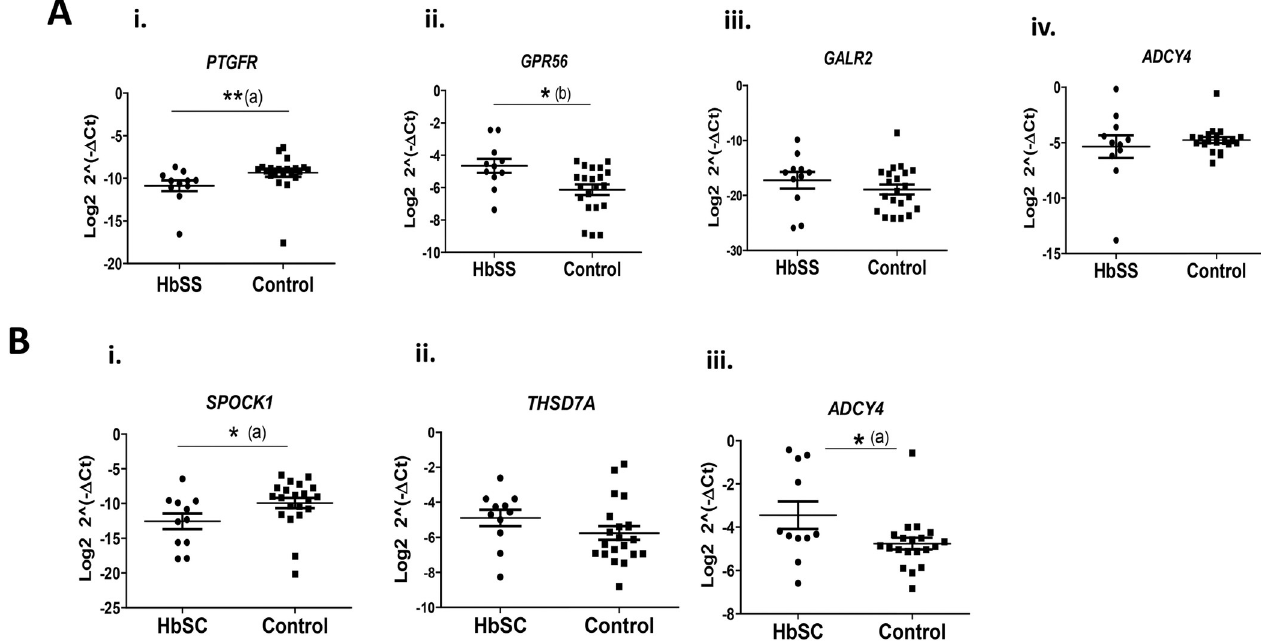
Fig 7. Expression levels of genes in the HbSS and HbSC groups compared with the control group (CON). A : Genes assessed in the HbSS group. i PTGFR ; ii GPR56 ; iii GALR2 and iv ADCY4 . B : Genes evaluated in the HbSC group. i SPOCK1 ; ii THSD7A and iii ADCY4 . � p < 0.05, �� p < 0.01, (a) Mann-Whitney U test, (b) Student’s unpaired t test.